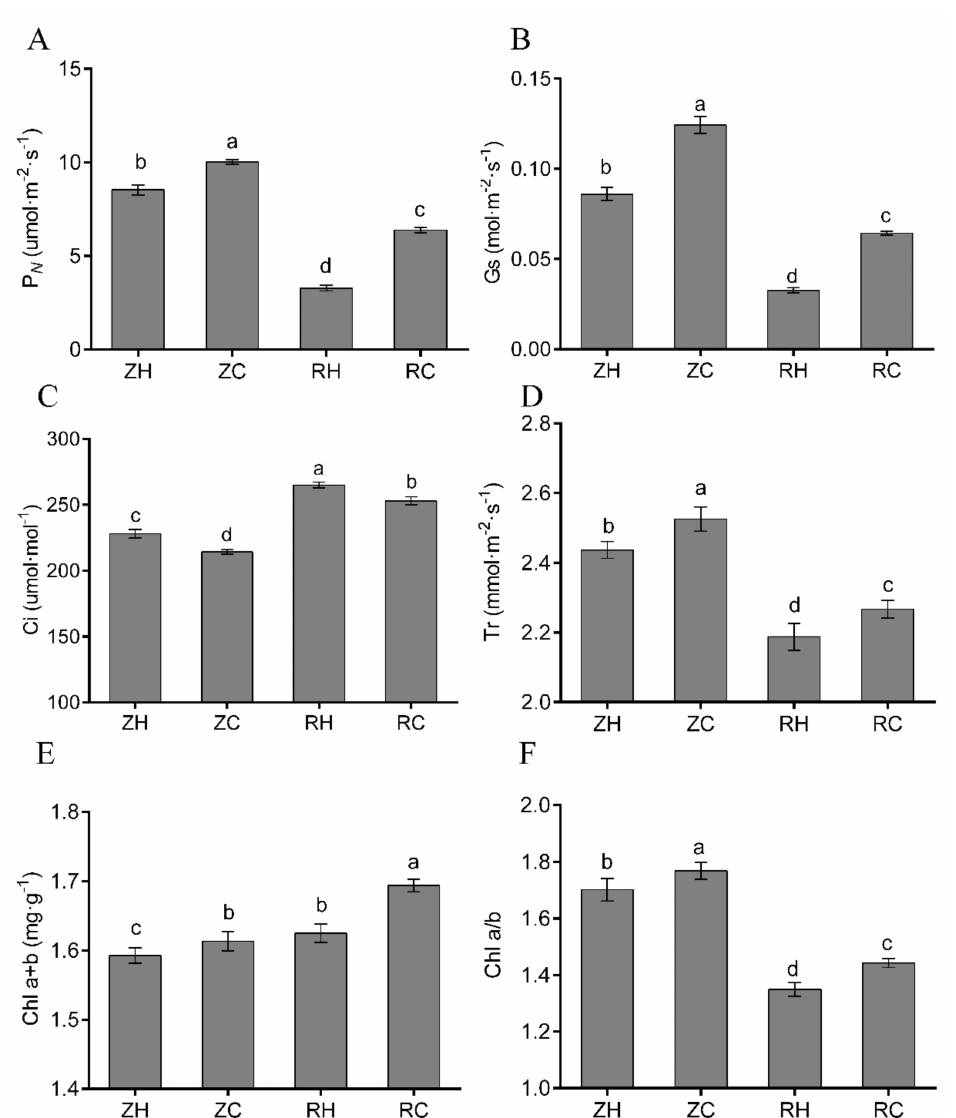
Figure 9. E ff ects of exogenous Ca 2 + and weak light on photosynthesis and chlorophyll content in potatoes. We measured the levels of ( A ) P N , ( B ) Gs, ( C ) Ci, ( D ) Tr, ( E ) chlorophyll and ( F ) chlorophyll a / b in di ff erent treatments. Values represent the mean ± S.E. ( n = 3). Letters indicate significant di ff erences at p < 0.05 according to Duncan’s multiple range